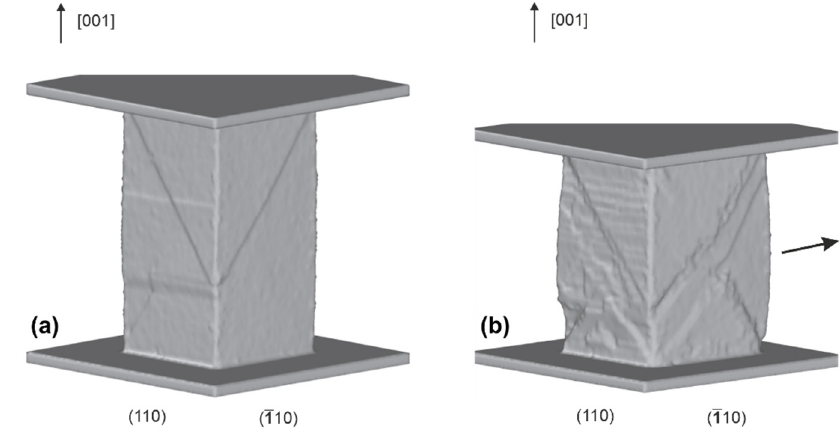
Figure 6. The deformation relief of simulated [001] ‐ single crystal, ε = 7% ( a ) and 24% ( b ) (the constrained deformation conditions, the free lateral face (cid:4666)1(cid:3364)1(cid:3364)0(cid:4667) ).